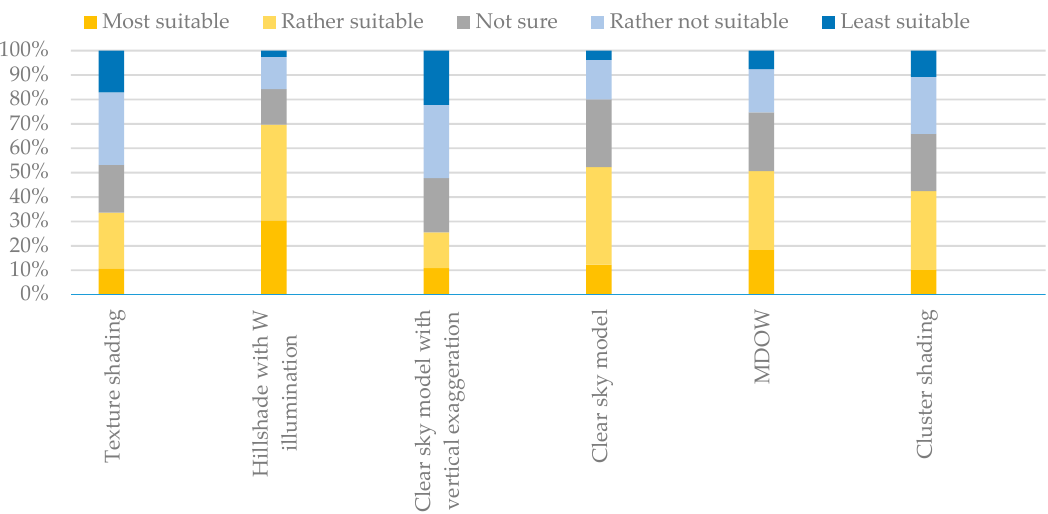
Figure 14. Survey results for alluvial fans.